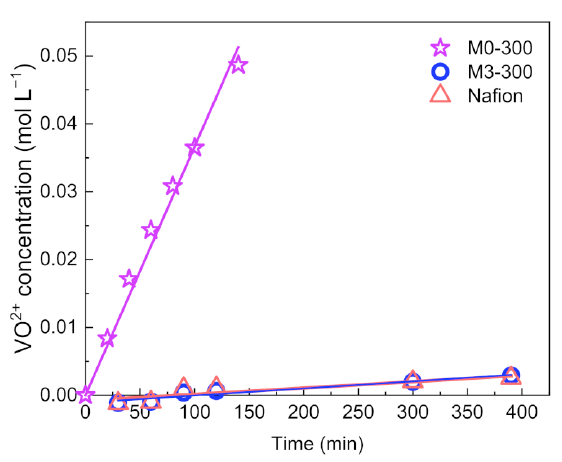
Figure 2. Vanadium ion permeability of M0-300, M3-300, and Nafion 212